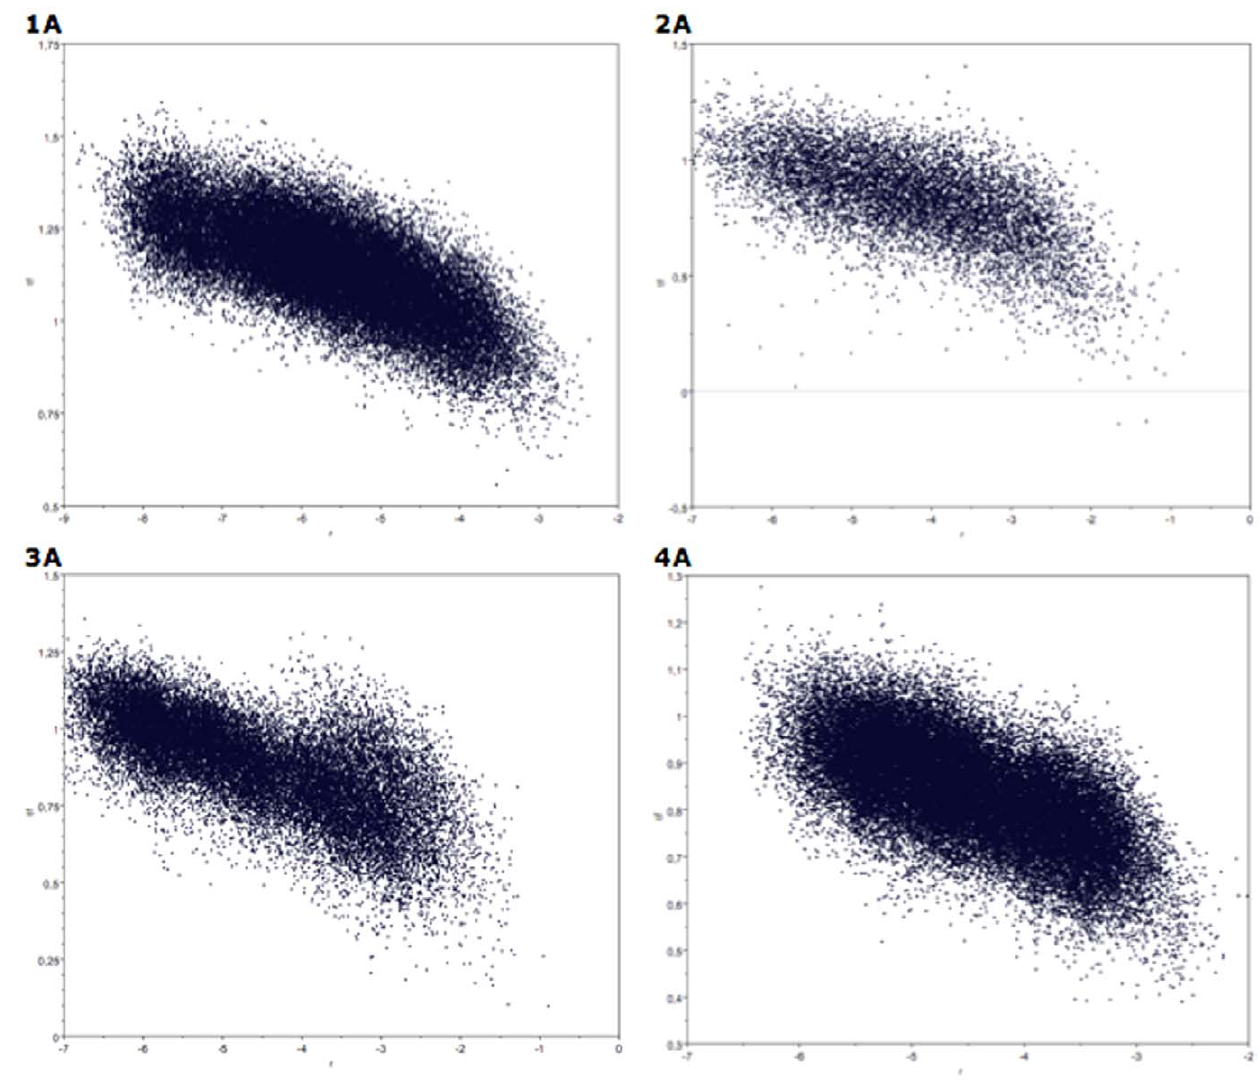
Figure 3. Plots of the simulated points from the marginal posterior distributions of log 10 ( r ) (x-axis) and log 10 (t f ) (y-axis). Samples labeled as in Table 3.